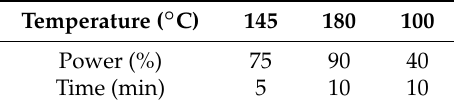
Table 3. The settings for mineralization of